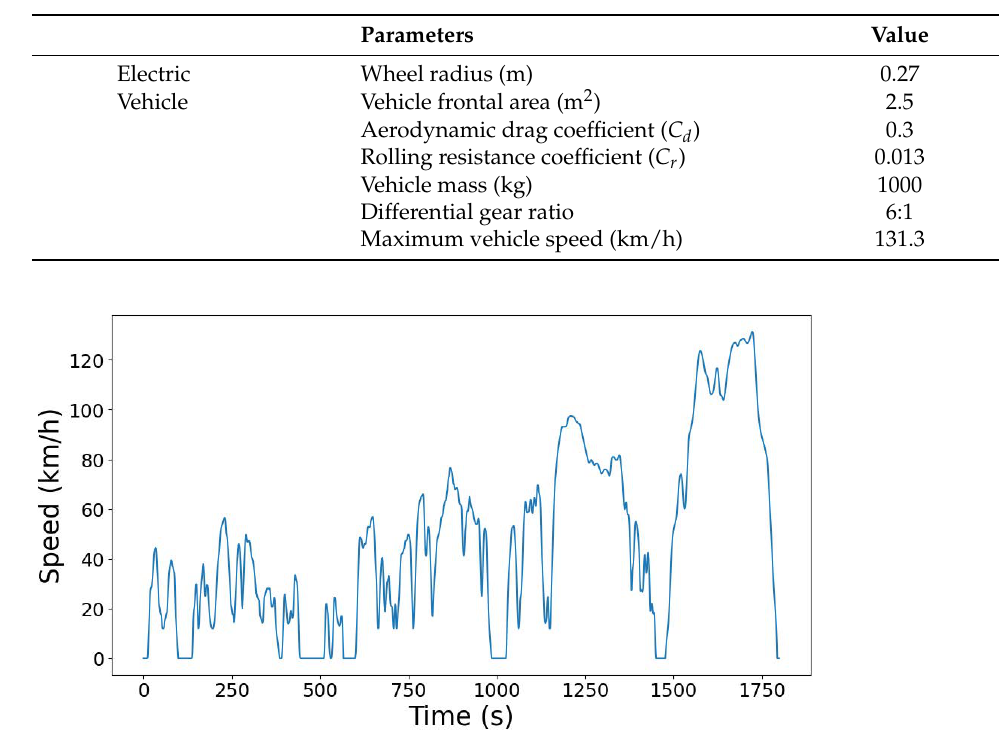
Figure 1. The power train of the light EV. Table 1. Specifications of proposed EV Design.